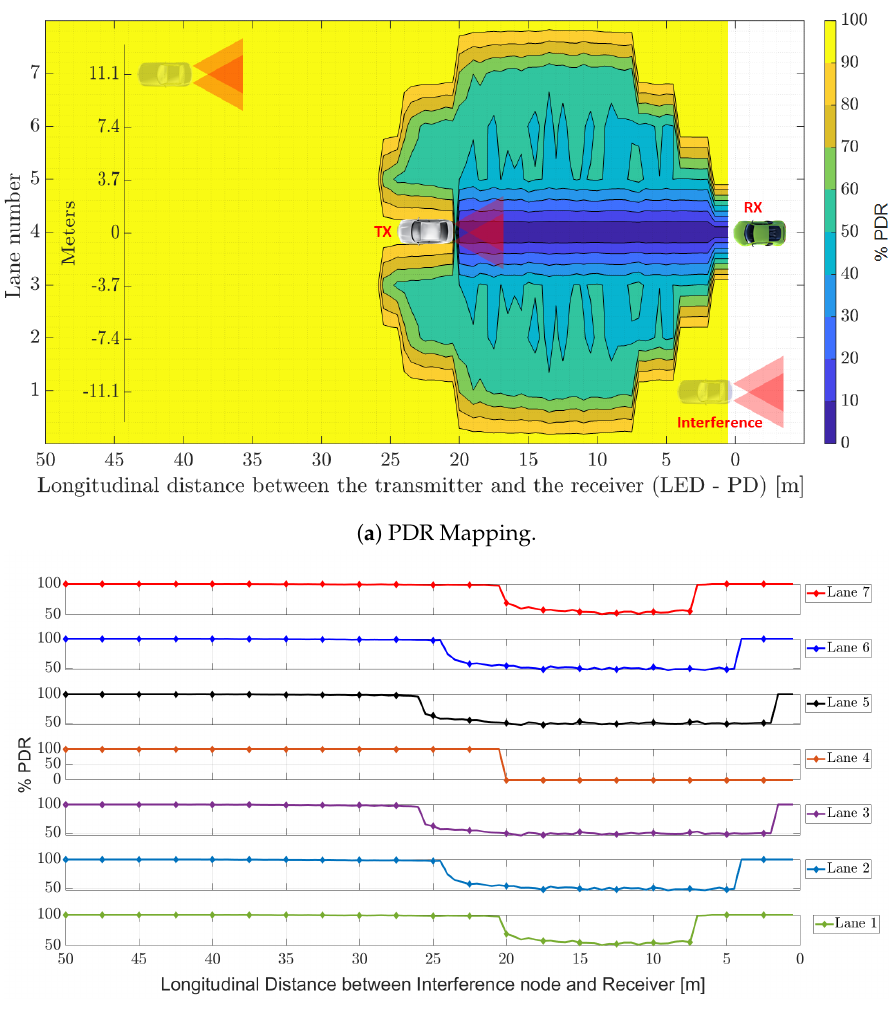
Figure 6. ( a ) View of PDR performance from above with MUI (blue vehicle) in V2V VLC without MAC, when transmitter (gray vehicle) and receiver (green vehicle) are in lane 4 of a seven-lane road with an inter-vehicle distance of 20 m; ( b ) Details of PDR